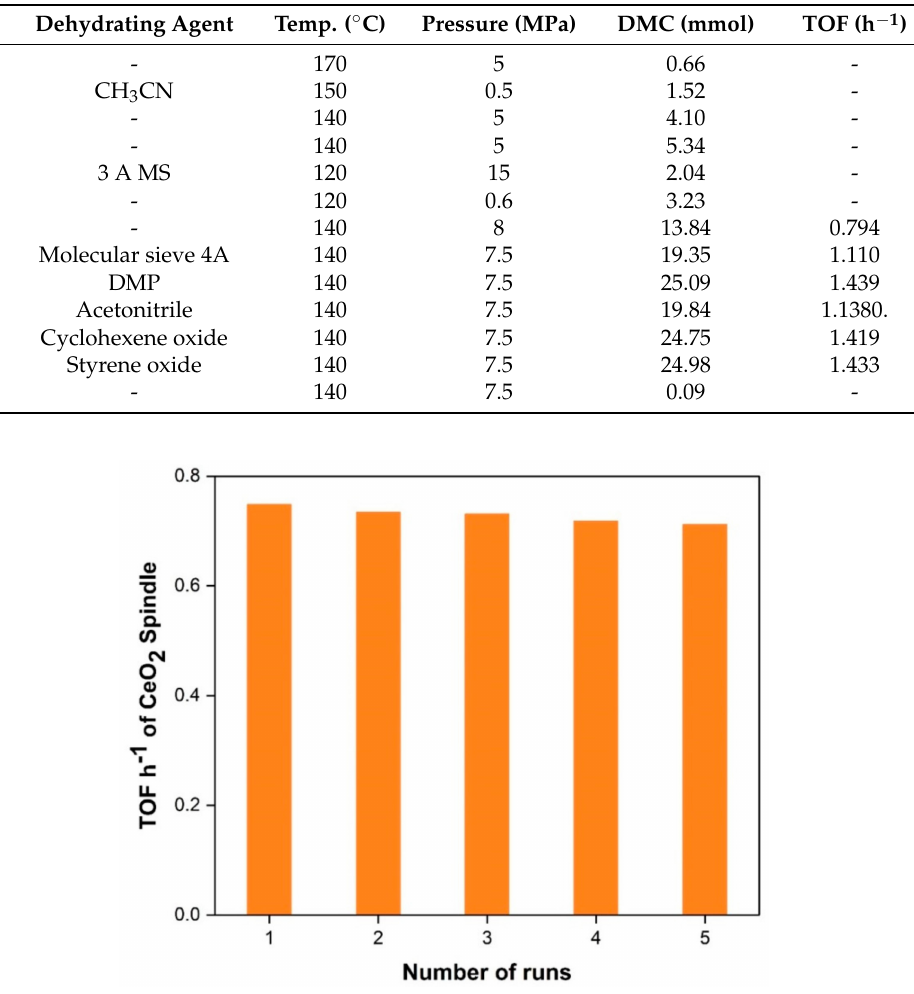
Table 3. Comparative results of cerium oxide catalysts for the direct synthesis of DMC from CO 2 and methanol.